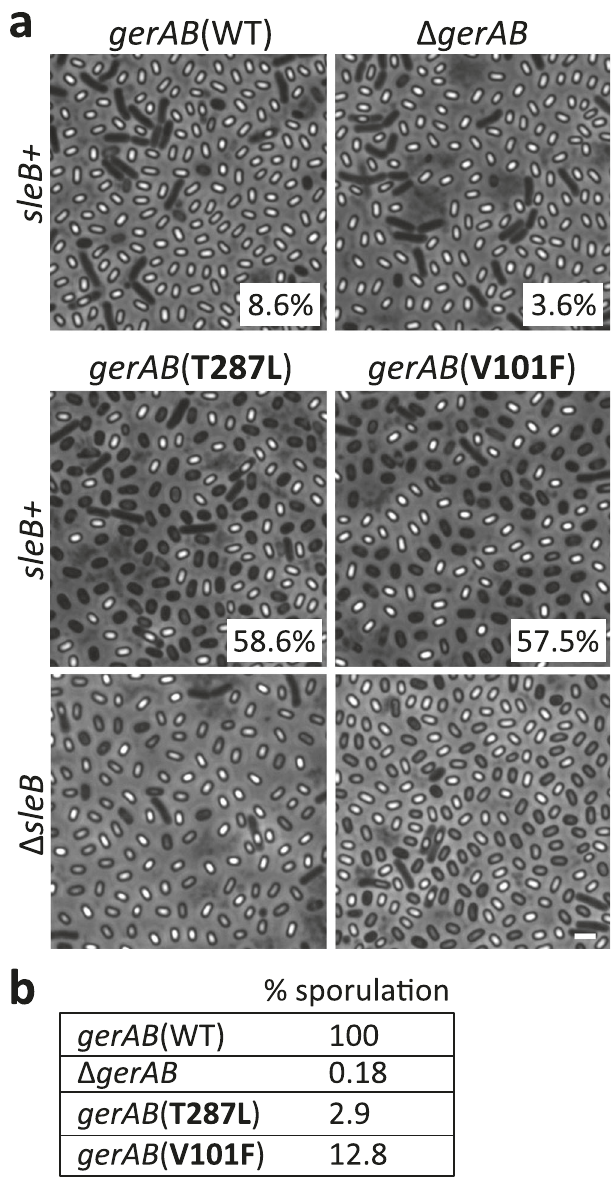
Fig. 4 Substitutions of bulkier residues in the putative ligand-binding pocket of GerAB cause premature germination. a Representative phase- contrast images of indicated strains after 30 h of sporulation. The majority of sporulating cells with wild-type gerAB or lacking gerAB produce phase- bright spores. By contrast, >50% of the cells harboring gerAB (T287L) or gerAB (V101F) produce phase-dark spores indicative of premature germination. Percentages of phase-dark spores are indicated in the corner of each image. Deletion of sleB encoding the spore cortex hydrolase that is activated during germination suppresses the phase-dark phenotype in the gerAB mutants. Larger fi elds can be found in Supplementary Fig. 10. Scale bar, 2 µ m. b Spore viability of the strains shown in a . Representative data from one of three biological replicates are